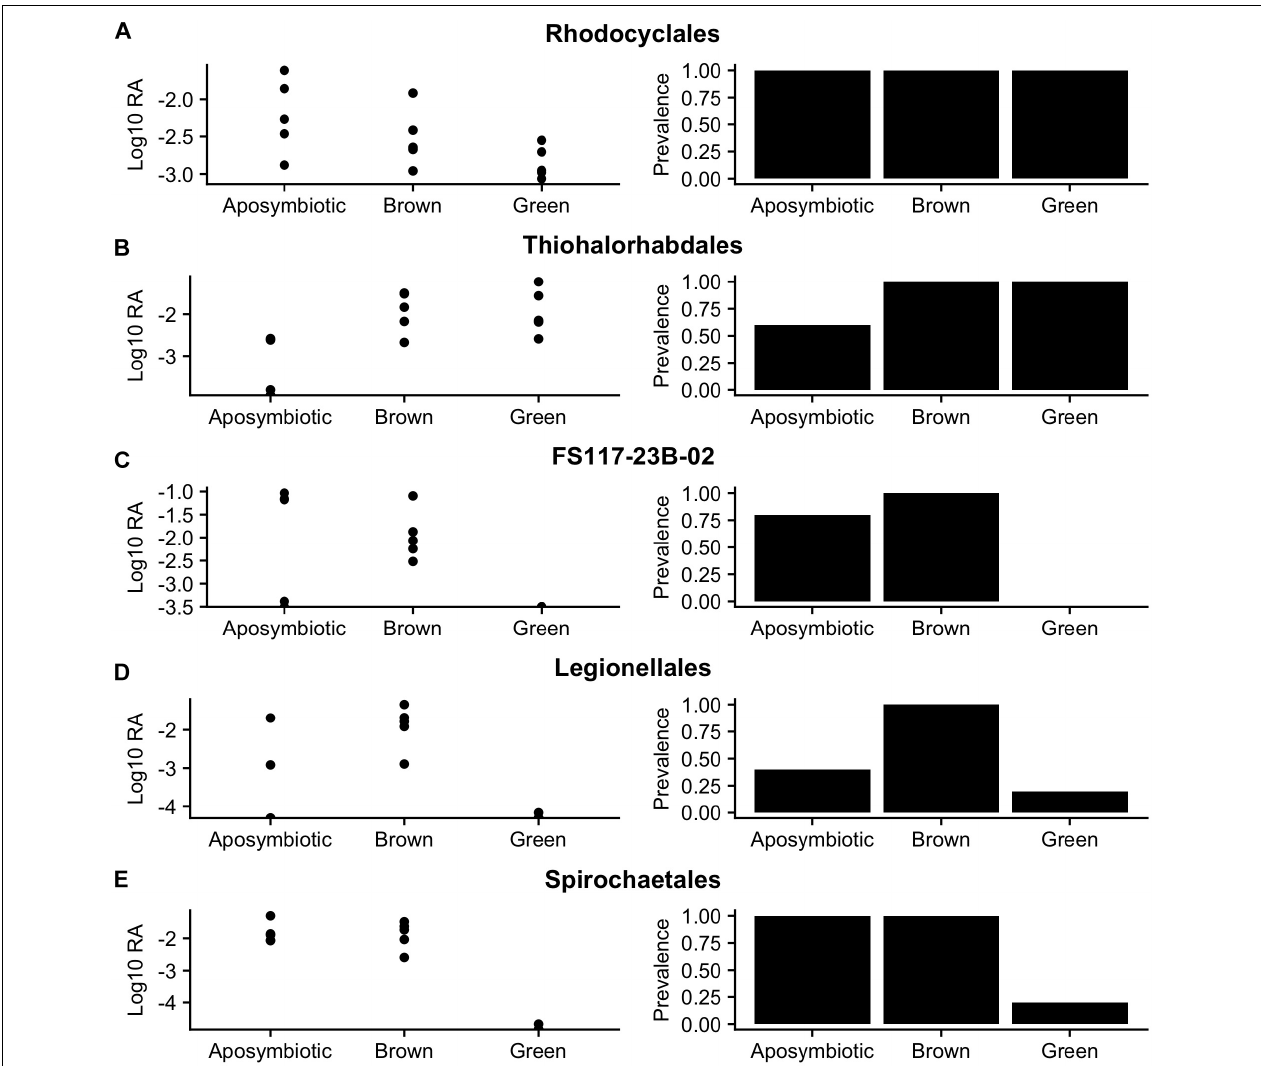
FIGURE 4 | Log10 relative abundances (left) and prevalence (right) reveal abundance and presence/absence patterns of orders identified as indicators of symbiotic state (FDR q -value < 0.2): (A) Rhodocyclales, (B) Thiohalorhabdales, (C) FS117-23B-02, (D) Legionellales, and (E) Spirochaetales.